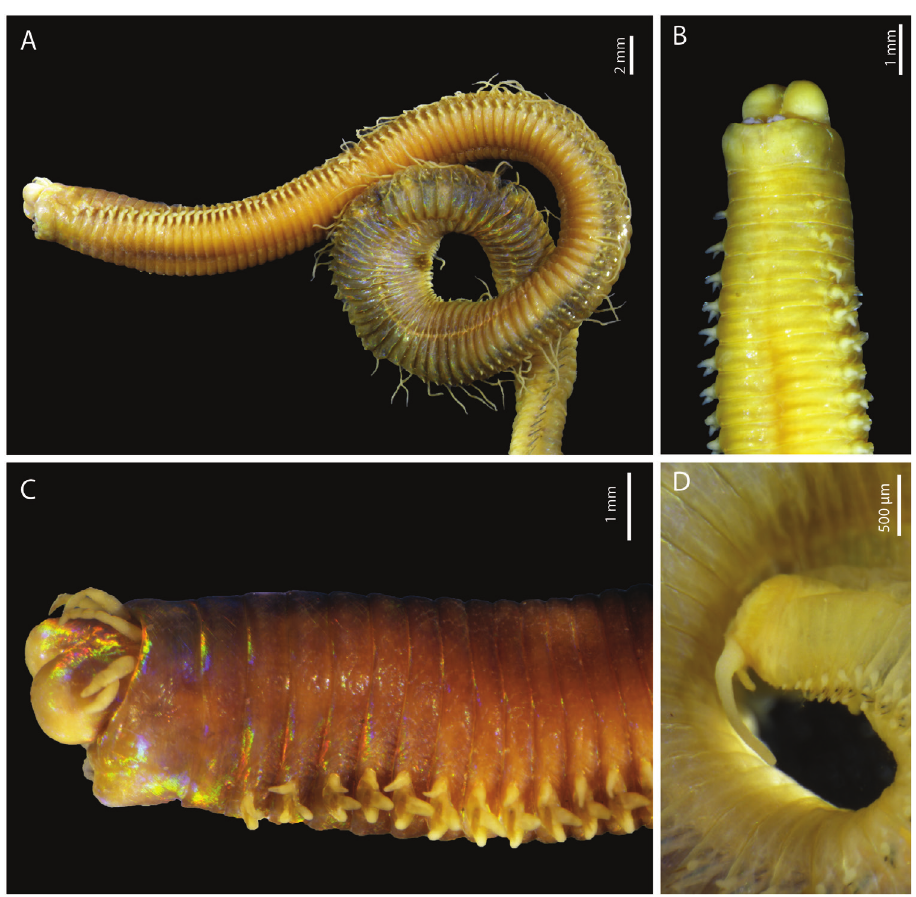
Figure 8. Marphysa zanolae sp. nov. holotype MNHN-IA-2015-1519 ( A, C, D ), paratype MNHN- IA-2015-1607 ( B ): A anterior end, lateral view B anterior end, ventral view C anterior end lateral view D